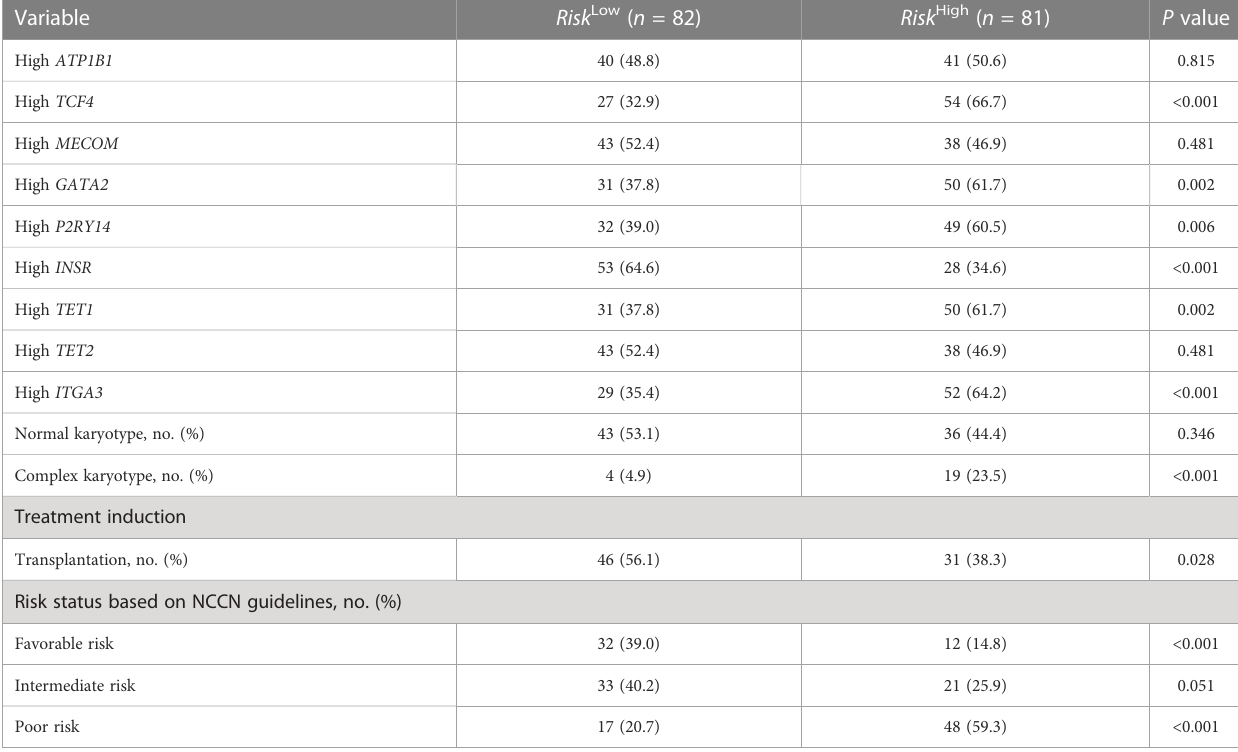
comparison of mutant and fusion genes in the two groups showed that the occurrence rate of CBFB – MYH11, RUNX1 – RUNX1T1 , and INSR increased signi fi cantly in the low – prognostic score group ( P = 0.005, P = 0.007, P < 0.001) and the occurrence rate of TP53 increased in the high – prognostic score group ( P < 0.001, Table 1). Moreover, in the high – prognostic score group, the genes DNMT3B ( P < 0.001), ITGA3 ( P < 0.001), and TCF4 ( P < 0.001) tended to be highly expressed (Table 1). The risk strati fi cation was performed as per the NCCN guidelines for the 163 samples. The number of patients with poor prognosis in NCCN strati fi cation in the high-score group was far more than that in the low-score group ( P < 0.001). Also, the number of patients with good prognosis in NCCN strati fi cation in the high-score group was signi fi cantly less than that in the low-score group ( P < 0.001, Table